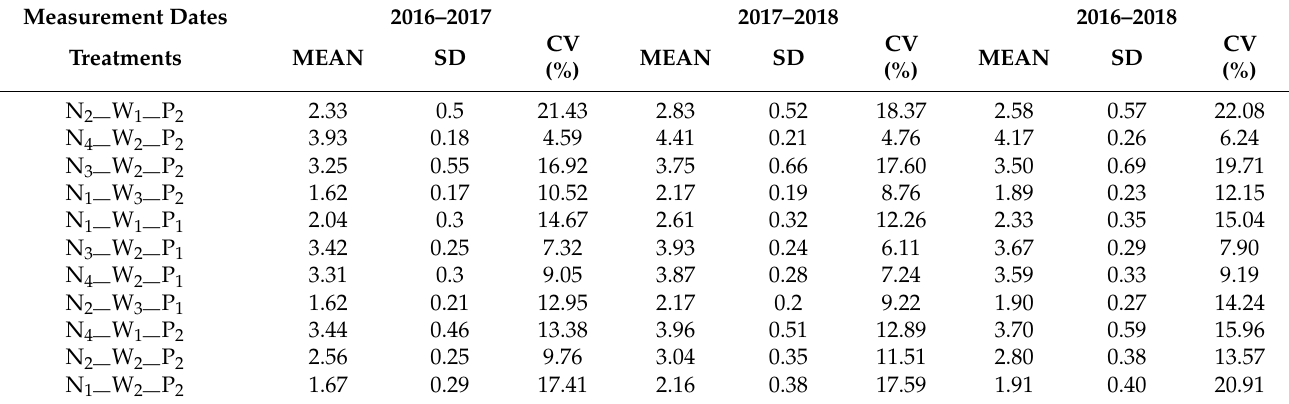
SD means standard deviation; CV means coefficient of variation. Table A3. Main statistical parameters of LAI at the jointing stage under different treatments. Measurement Dates